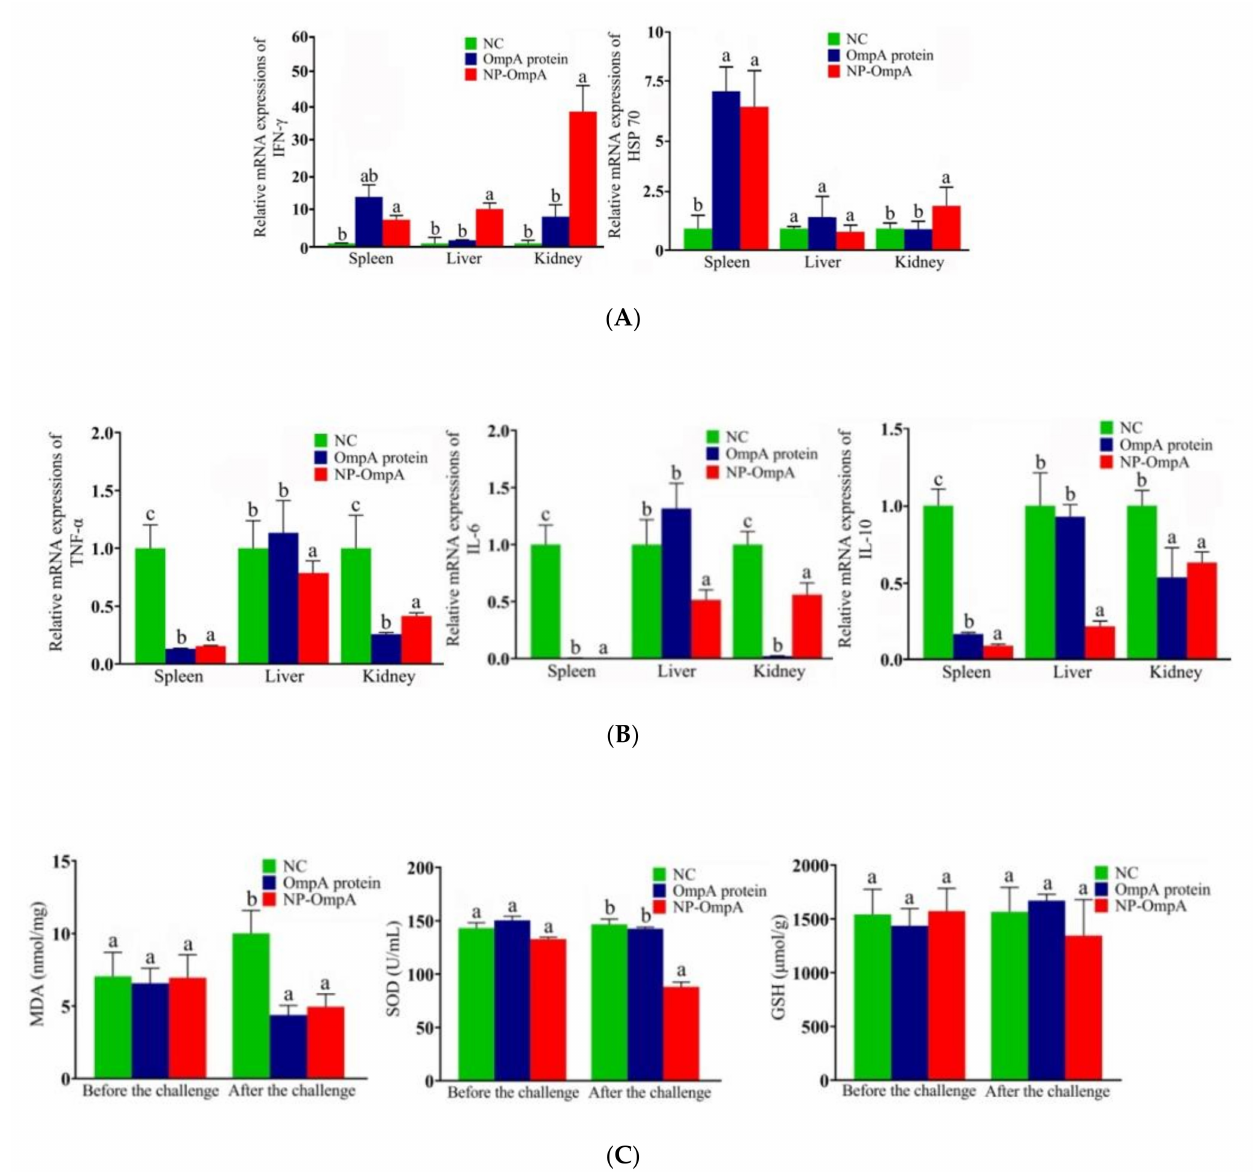
Figure 7. Analysis of immune-related factors before and after pathogenic E. coli challenge in mice. Labels a–c indicate statistically different groups ( p < 0.05). ( A ) Effect of NP-OmpA on mRNA expression of immune-related factors before the challenge. Compared to NC and OmpA, NP-OmpA activated higher expression levels of IFN- γ and HSP70 in the spleen, liver, and kidney. ( B ) Effect of NP-OmpA on mRNA expression of inflammation-related factors after challenge. Compared to NC, NP-OmpA and OmpA resulted in decreased expression levels ( p < 0.05) of TNF-a, IL-6, and IL-10 in the spleen, liver, and kidney, especially in the spleen. ( C ) Levels of antioxidant-related factors before and after E. coli challenge. After the challenge, animals immunized with NP-OmpA and OmpA had lower MDA and SOD liver levels than those that received NC, and the level was lower in those immunized with NP-OmpA compared to